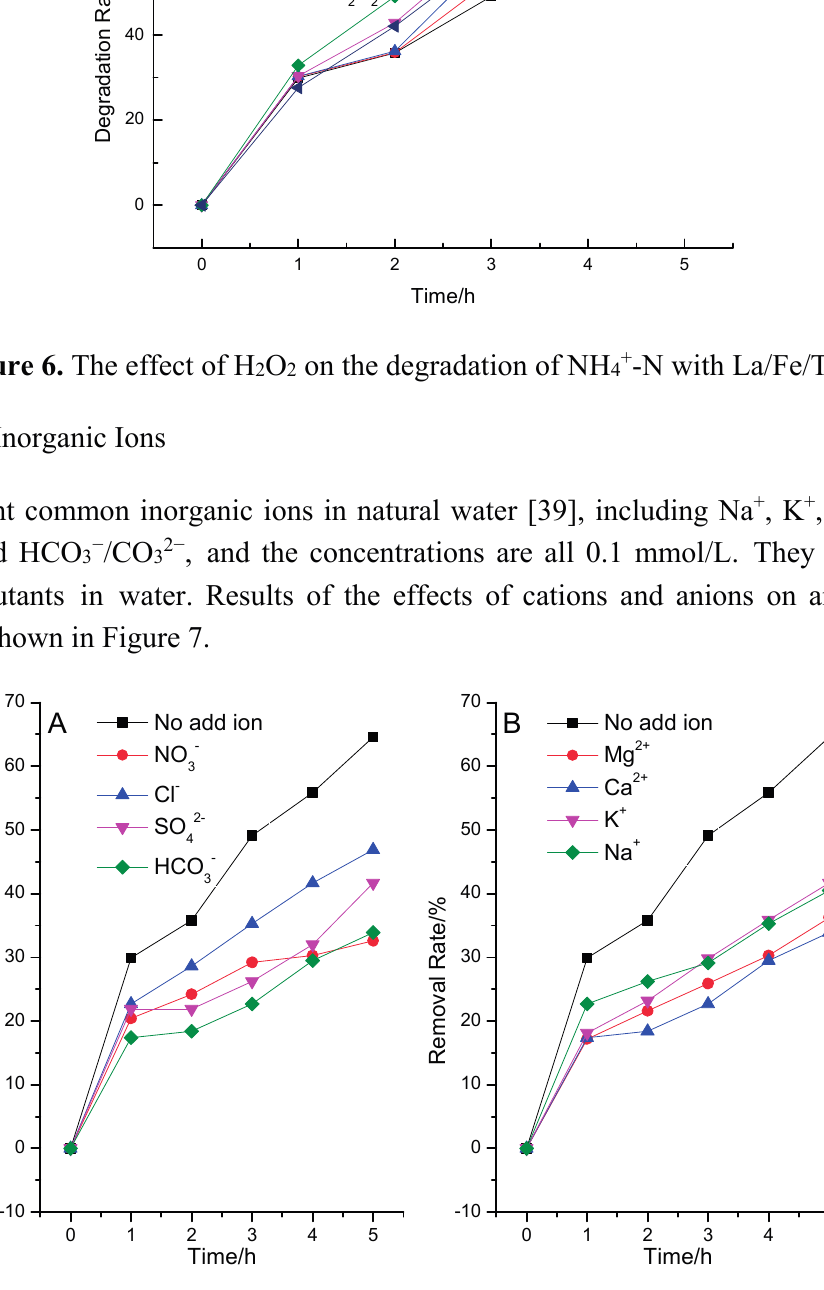
Figure 7. The effect of ions on the degradation of NH 4+ -N with La/Fe/TiO 2